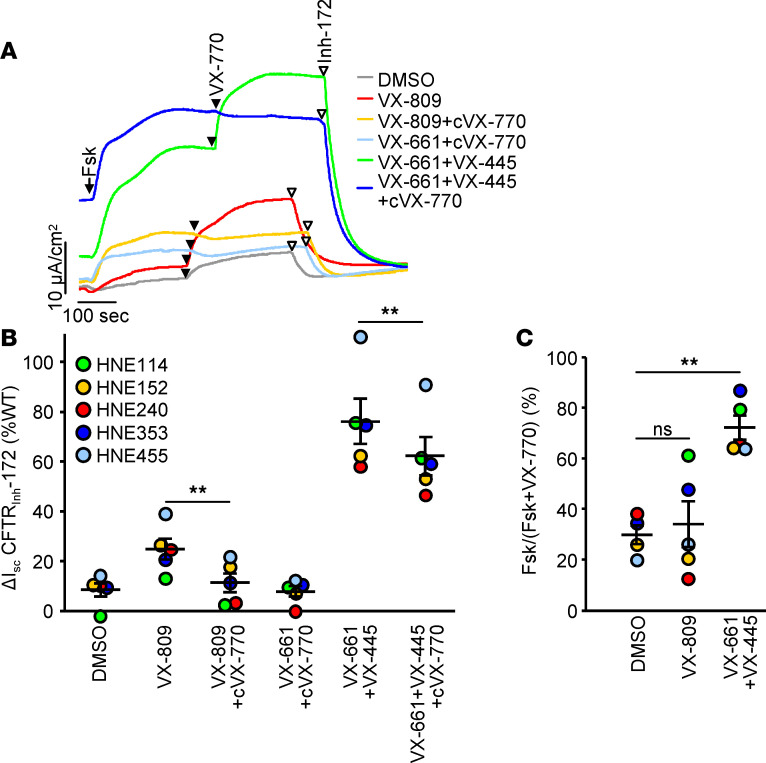
Trikafta mediated correction of CFTRF508del/F508del in HNE.(A) Effect of indicated single correctors or corrector combinations on the Isc of human nasal epithelia with CFTRF508del/F508del genotype (CF-HNE). CFTR-mediated currents were induced by sequential acute addition of forskolin (Fsk, 20 μM, arrow) and VX-770 (770, 10 μM, filled arrowhead), followed by CFTR inhibition with CFTRinh-172 (Inh-172, 20 μM, open arrowhead) in intact monolayers with basolateral-to-apical chloride gradient. (B) Quantification of the CFTRinh-172 inhibited current, after stimulation as in A, in CF-HNE isolated from 5 different homozygous F508del CF patients after single correctors (VX-809 and VX-661, 3 μM; VX-445, 2 μM; 24 hours, 37°C), corrector plus chronic potentiator (cVX-770, 1 μM, 24 hours, 37°C) or corrector combination treatment expressed as percentage of WT-CFTR currents in WT-HNE from 10 donors. **P < 0.01 by paired 2-tailed Student’s t test. (C) The fraction of potentiator-independent (forskolin-induced) current in HNE treated with single corrector or corrector combination. **P < 0.01 by paired 2-tailed Student’s t test followed by Bonferroni’s FDR correction.